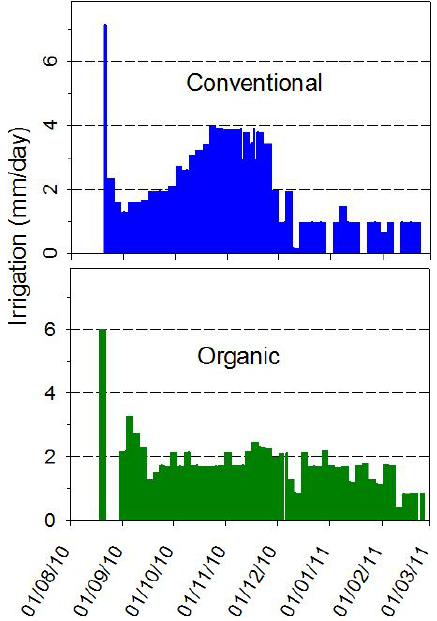
Fig. 2. Daily irrigation during a single growing season of tomato in the organic and conventional